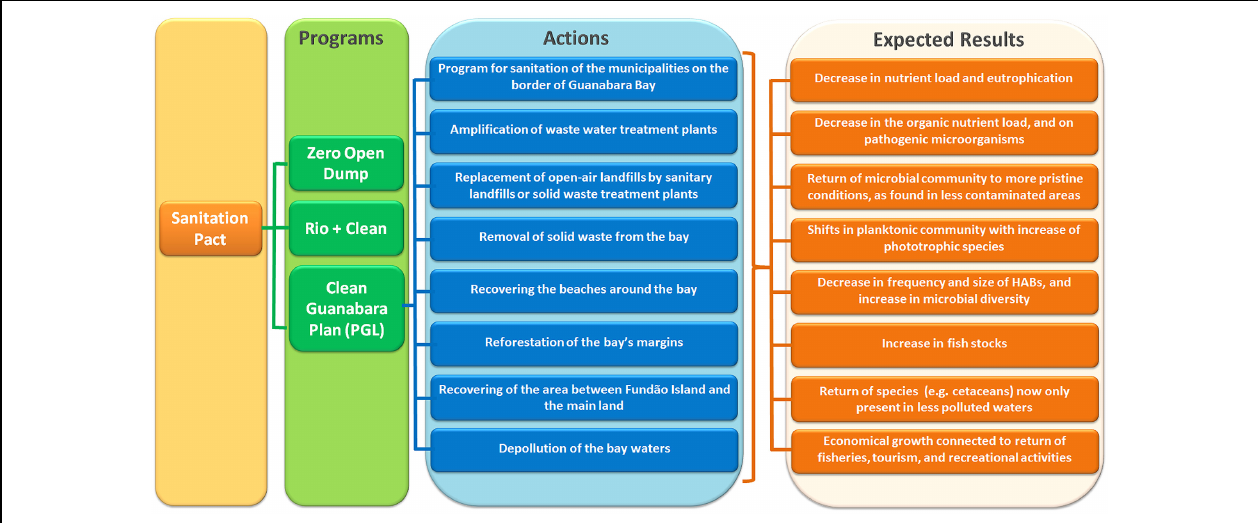
FIGURE 6 | Flowchart showing the three programs in which the Sanitation Pact, enacted by the state of Rio de Janeiro, is divided in. From these three programs, the Clean Guanabara Plan (PGL) will tackle the pollution problems of Guanabara Bay, and it is divided in eight actions shown in the